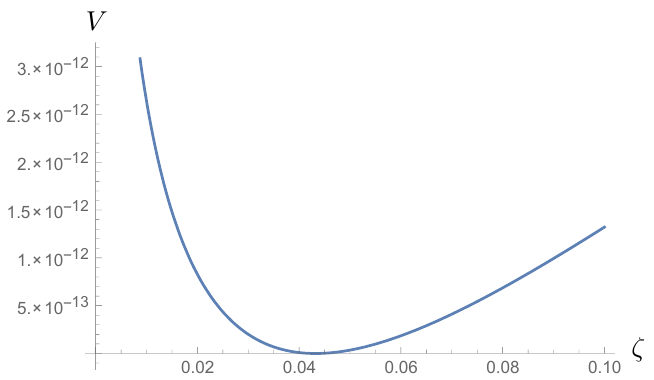
Figure 1 . Potential V ( (cid:16) ) for (cid:27) 0 = 0 and the choice of parameters: M = 4, K = 1, g s = 1 = 2 and (cid:28) = 10 3